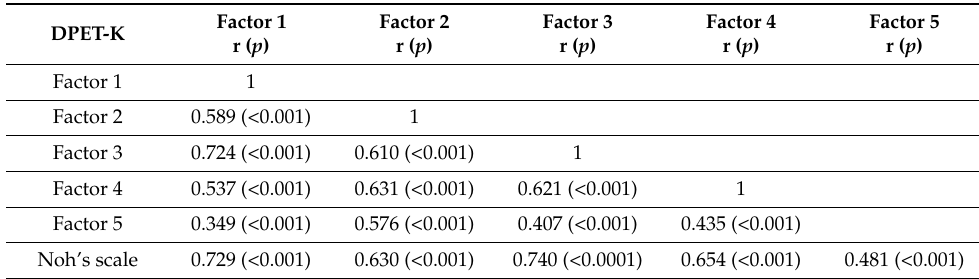
Table 5. Concurrent validity between the Korean disaster preparedness evaluation tool and Noh’s scale ( N =